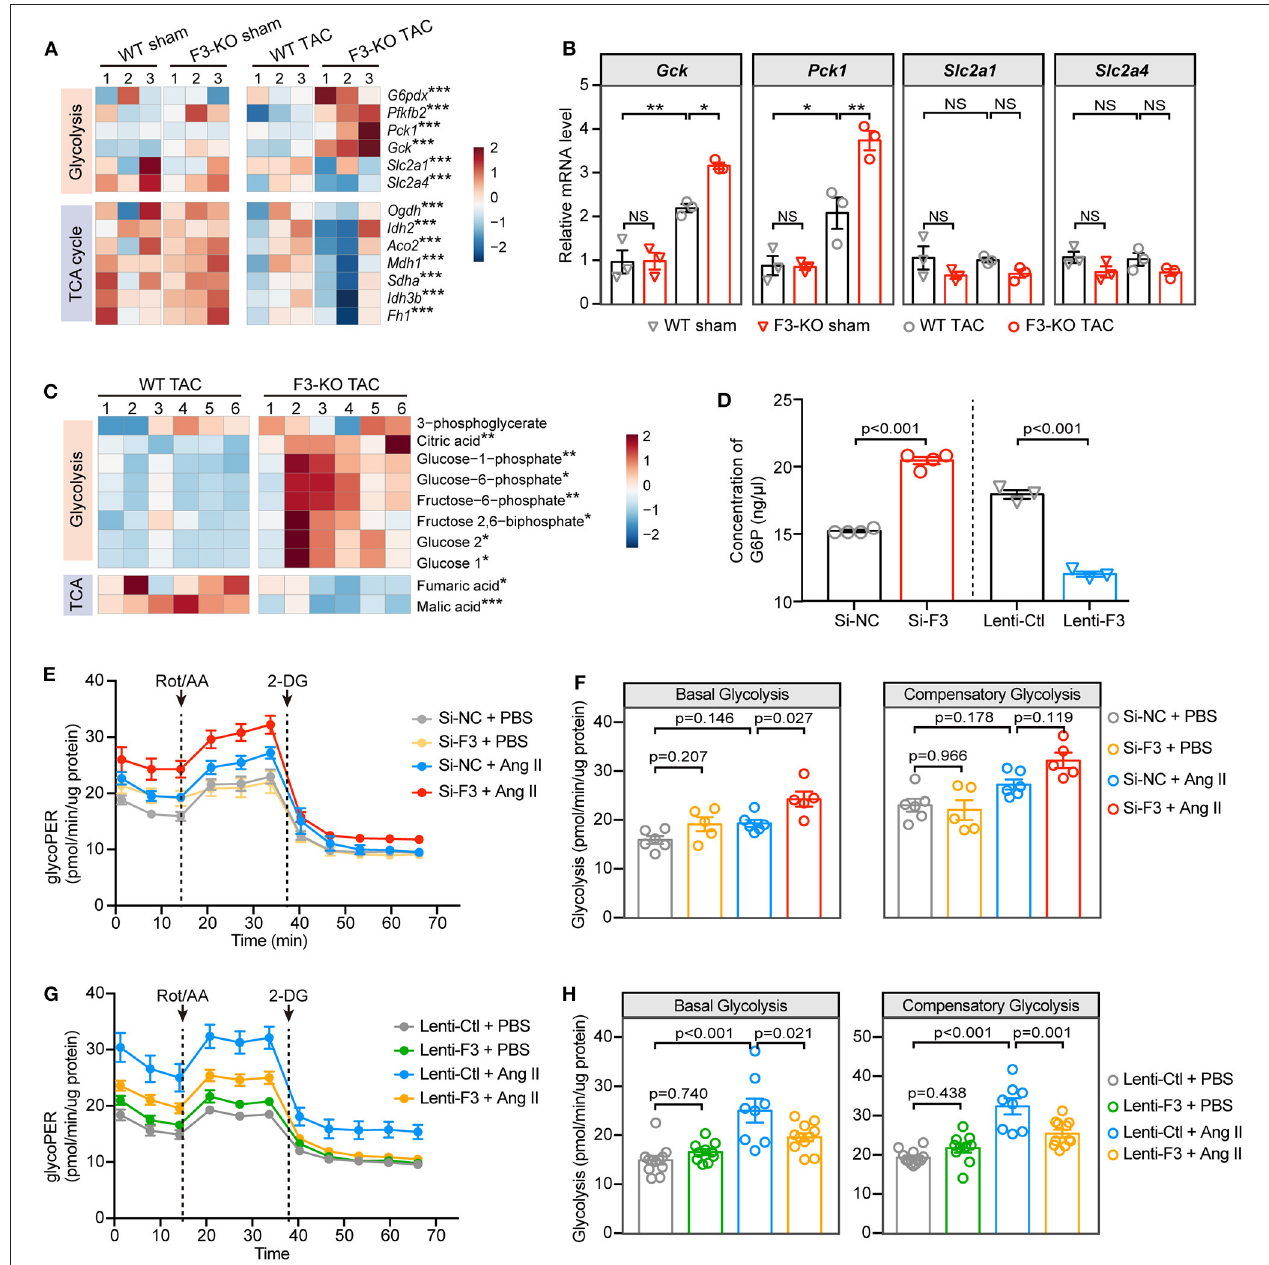
FIGURE 5 | FABP3-null contributes to increased glycolysis and reduced ATP production under hypertrophic stimulation. (A) Heatmap of glycolysis and TCA cycle genes from RNA-seq analysis. (B) The mRNA expression of Gck , Pck1 , Slc2a1 , and Slc2a4 in indicated groups. NS, not significant, * p < 0.05, ** p < 0.01. (C) Heatmap of differential metabolites from WT and F3-KO hearts. * p < 0.05, ** p < 0.01, *** p < 0.001. (D) The intracellular concentration of glucose-6-phosphate (G6P) in NRVMs was measured after manipulating the expression of Fabp3 . (E) Glycolytic rate assay was performed in NRVMs after knocking down the expression of Fabp3 with siRNA to measure the OCR and extracellular acidification rates (ECAR) and converted to glycolytic proton efflux rate (glycoPER) in the Seahorse Report Generator. (F) The parameters of basal glycolysis and compensatory glycolysis were calculated from (E) . Data were presented as mean ± SEM from individual experiments. (G) Glycolytic rate assay was performed in NRVMs with or without Fabp3 overexpression to measure glycoPER. (H) The parameters of basal glycolysis and compensatory glycolysis were calculated from (G) . Data were presented as mean ± SD from individual experiments. [ B , n = 3, Tukey’s post-hoc test; D , n = 4, 4, 3, 3, respectively, Student’s t -test; F , n = 6, 5, 6, 5, respectively; H , n = 12, 10, 8, 11, respectively; (F,H) Tukey’s post-hoc